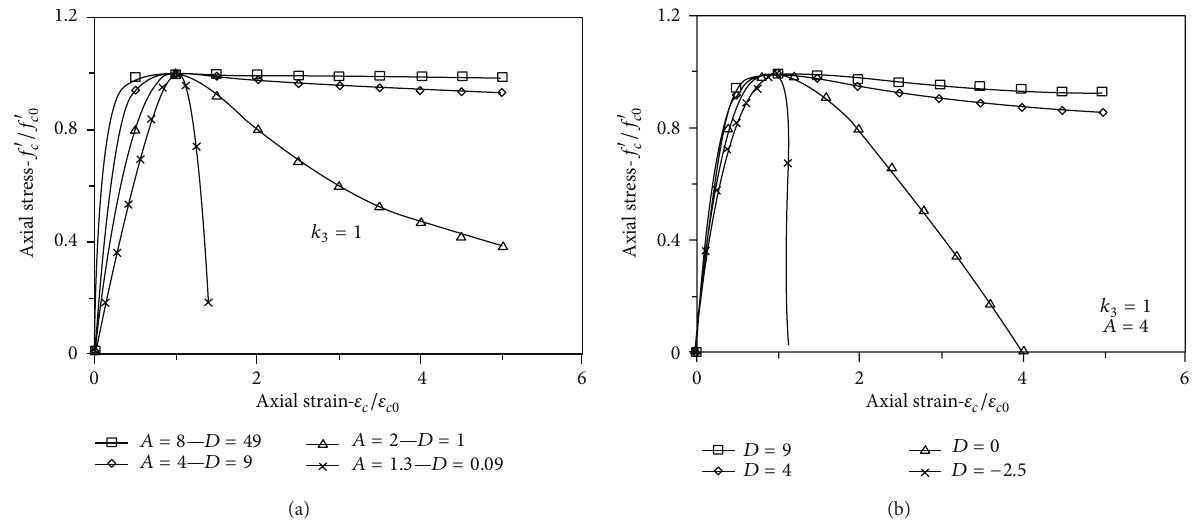
Figure 2: Variation of stress-strain relationship of Sargin [13] with the variation in the 𝐴 and 𝐷